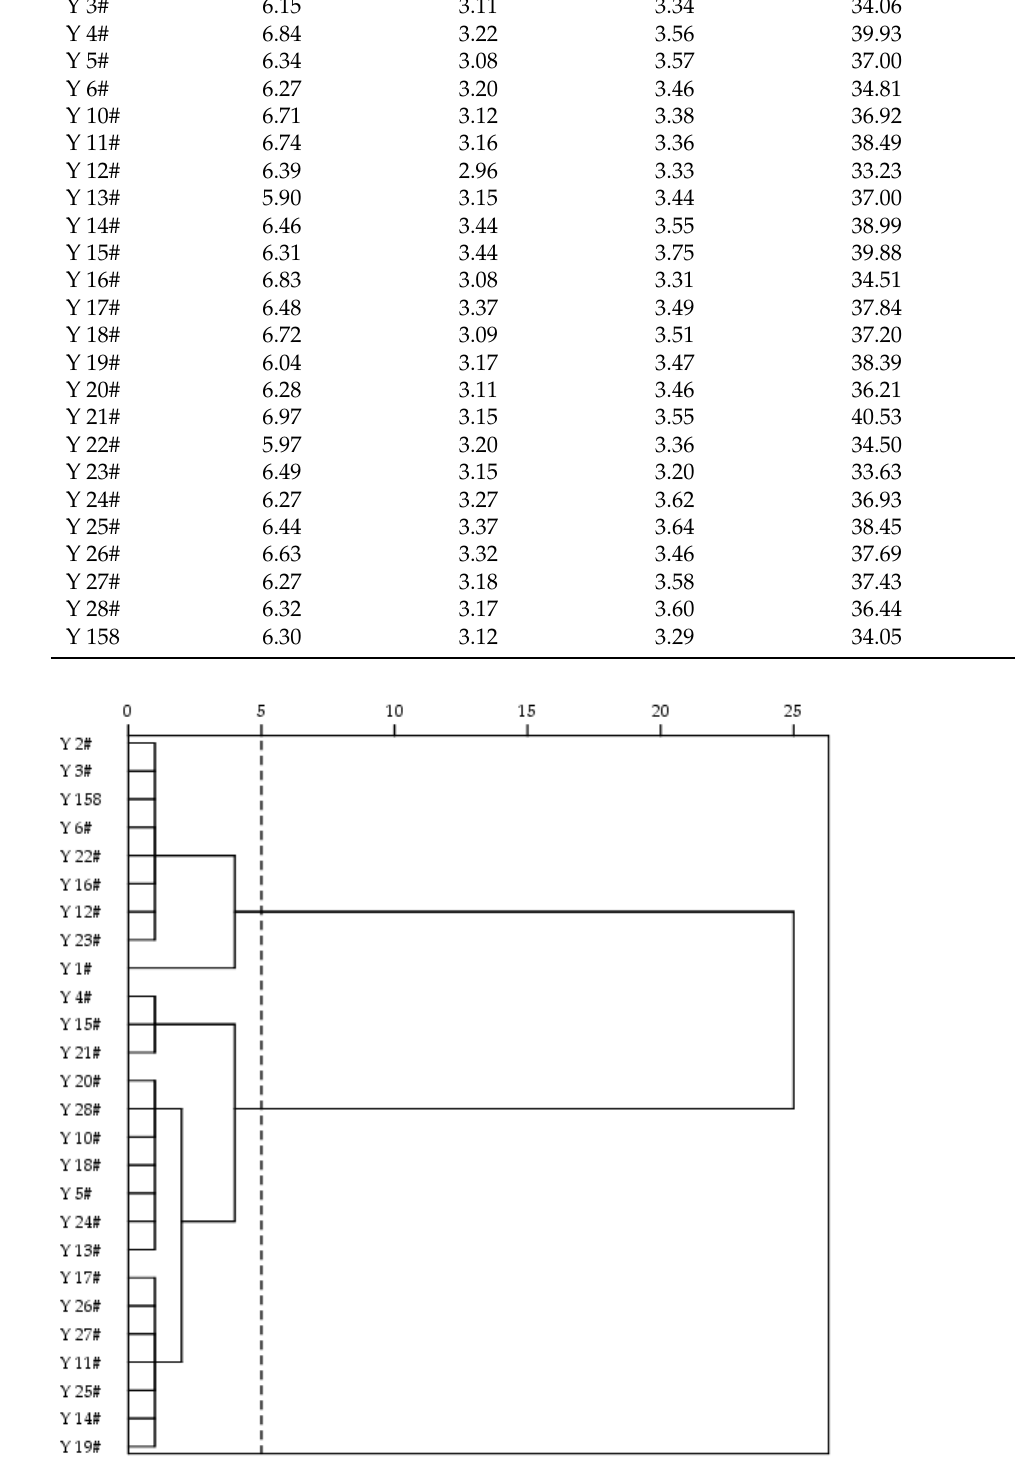
Figure 12. Cluster analysis of 3D morphological of Yangmai series varieties.